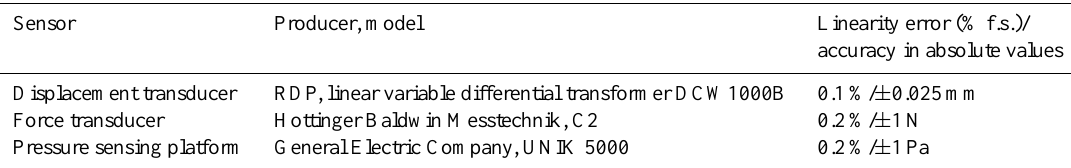
Table 1. Description of sensors.